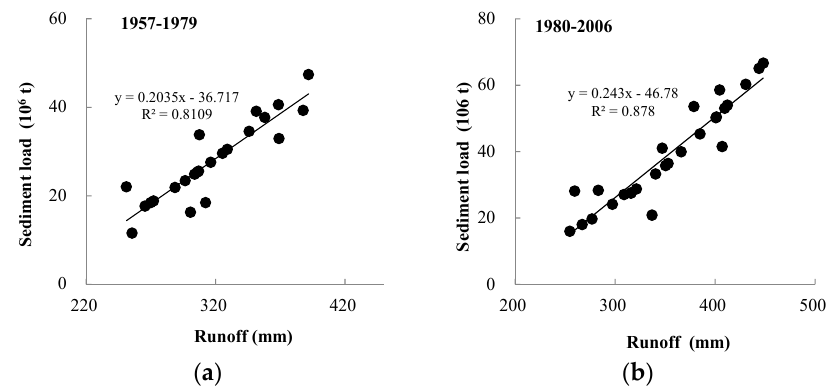
Figure 5. Scatter plots between annual runoff and sediment load during the periods of 1957 – 1979 and 1980 – 2006 at Jiuzhou Station.